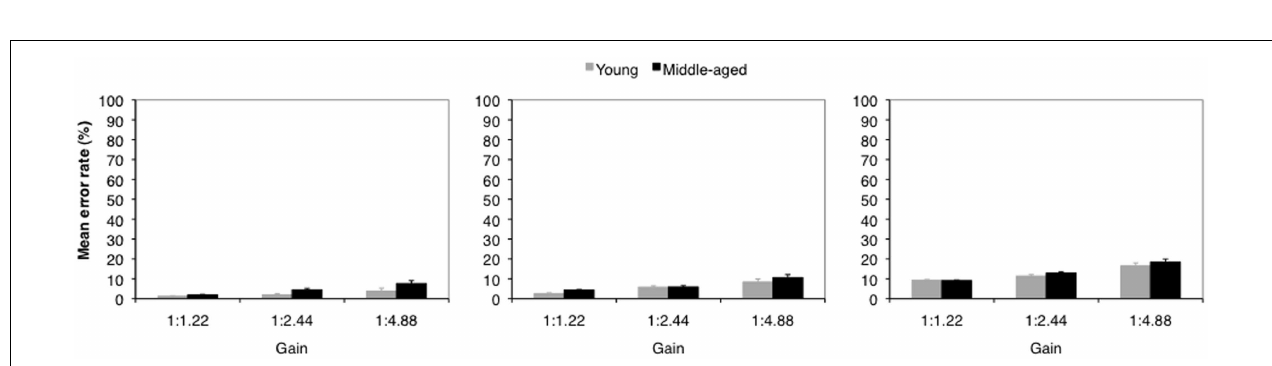
FIGURE 2 | Mean movement times of younger (gray) and middle-aged (black) adults as a function of gain for a hand amplitude of 20mm (left), 40mm (middle), and 60mm (right). Error bars represent the standard error of the mean.